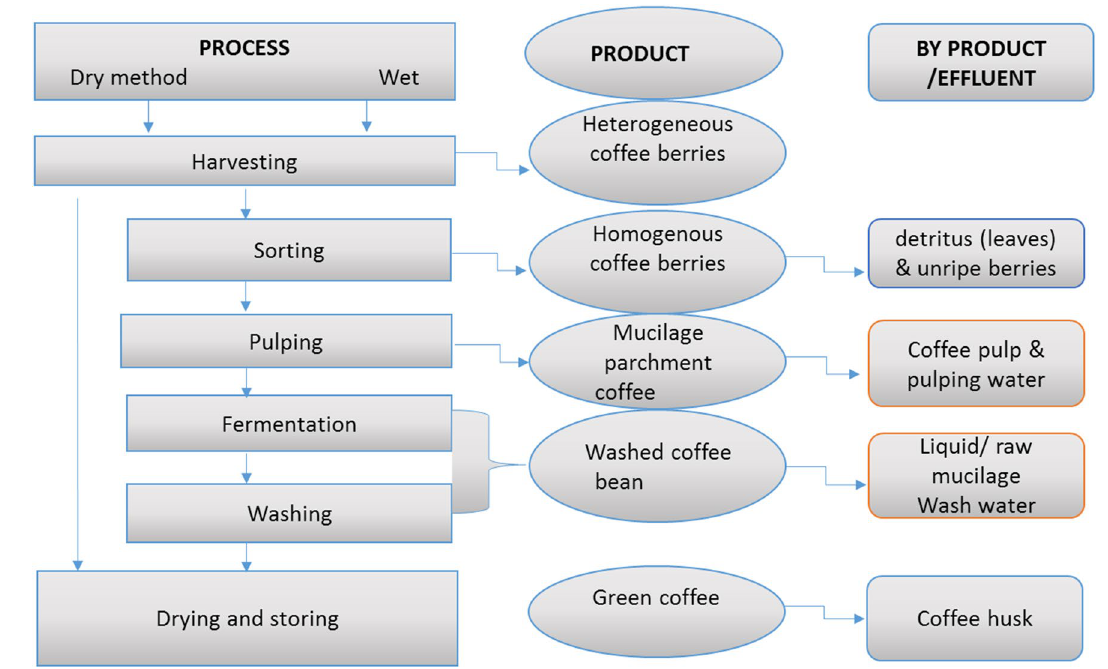
Fig. 2 Schematic diagram of coffee processing. Source :